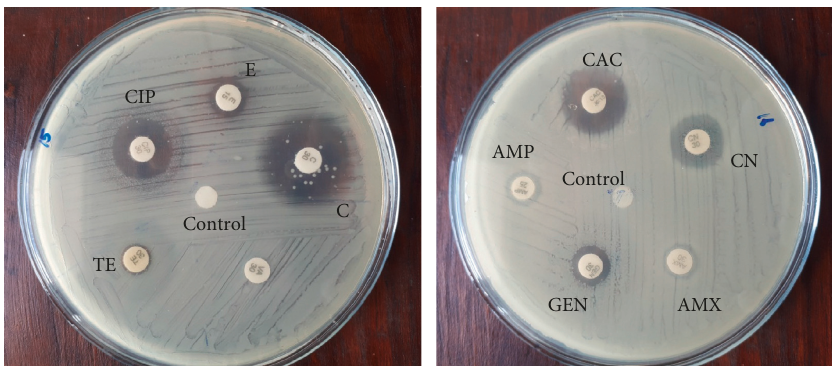
Figure 2: E. coli samples showing multiple antimicrobial resistance (MAR).